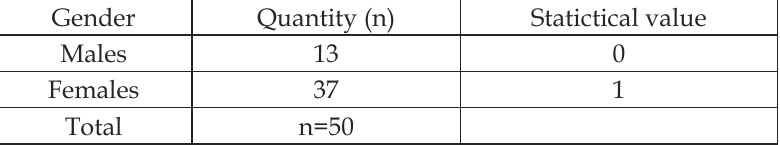
Table 3 . The gender distribution in the research sample Gender